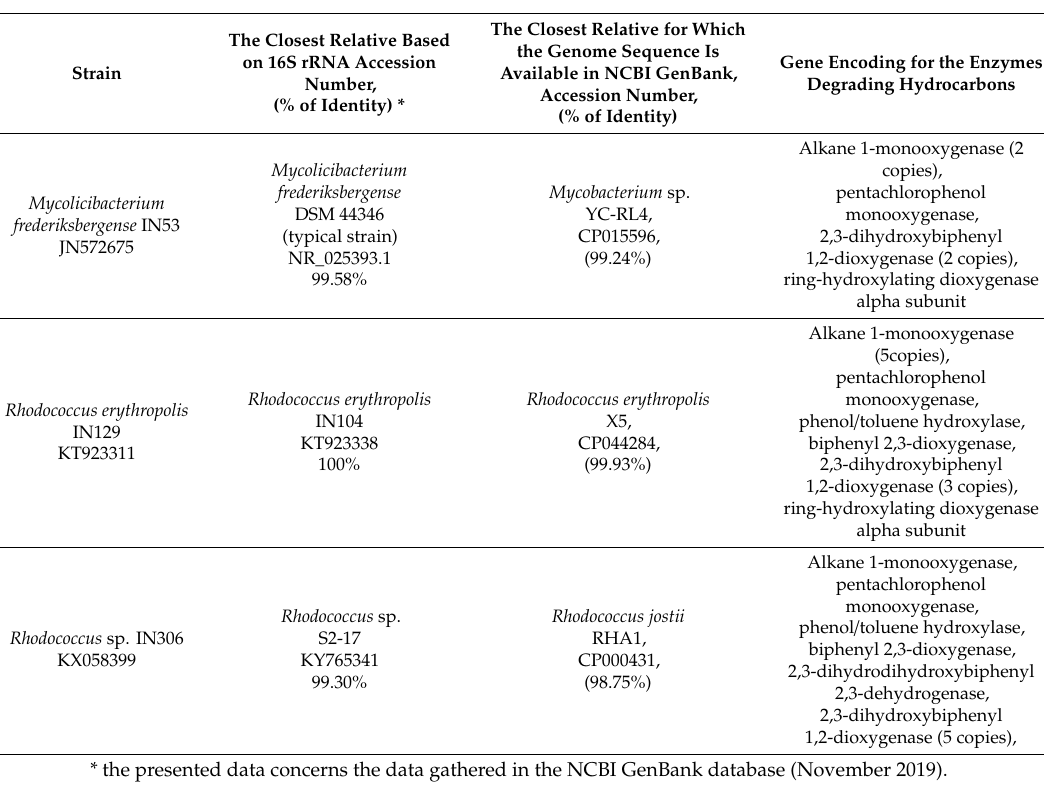
Table 1. Genes involve in biphenyl and hydrocarbon degradation, found in genomes of the closest relatives of IN53, IN129 and IN306.